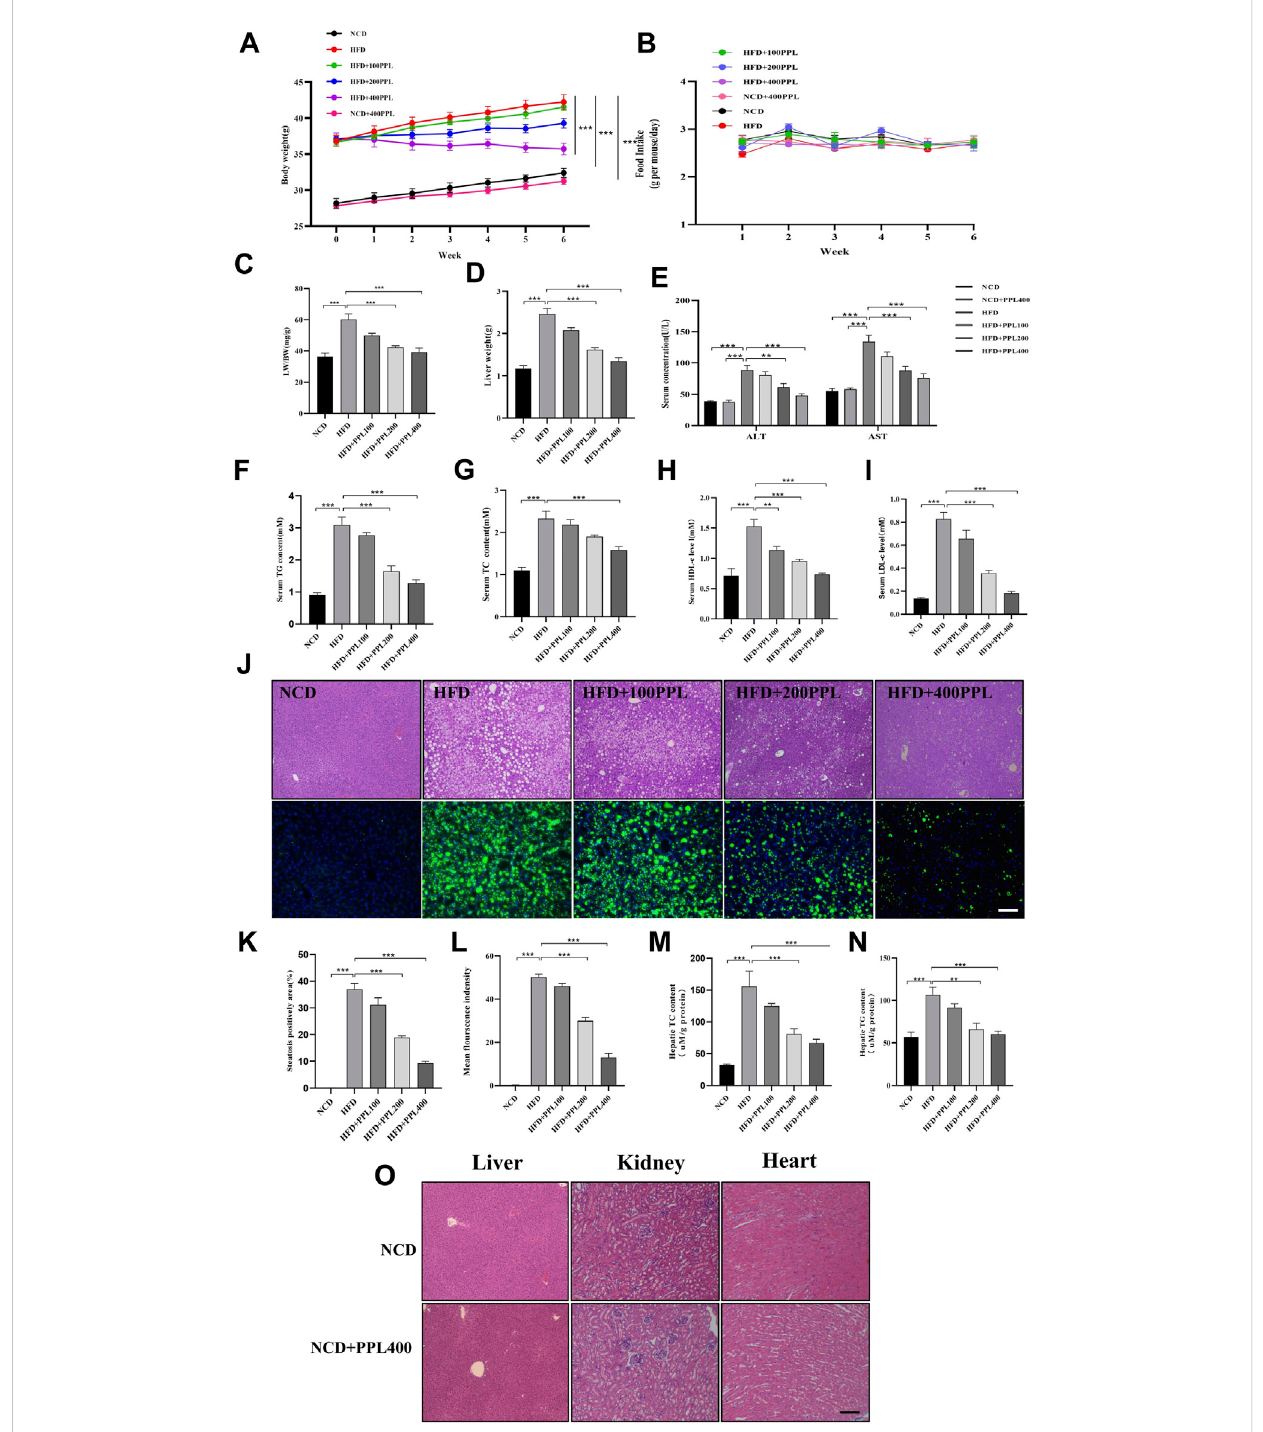
FIGURE 1 PPLalleviatedHFD-inducedobesityand liversteatosisinmale C57BL/6mice. (A) Body weightofHFD-inducedobeseC57BL/6mice werefedeither in the presence or absence of PPL. (B) Weekly food intake pro fi le. (C) LW/BW ratio. (D) Liver weight. (E) Serum ALT and AST activity. (F – I) Serum lipid contentsofTG,TC,HDL-c,andLDL-clevels. (J) TypicalimagesofHE(top)andBODIPY493/503(bottom)stainingofliversections. (K) Steatosispositively area. (L) BODIPY positively stained area. (M,N) Hepatic TC content and TG content. (O) Typical images of HE staining from liver, kidney and heart sections. Magni fi cation: ×200, scale bar: 100 μ m. Data were expressed as the mean ± SEM. Differences among groups were compared by one-way ANOVA. * p < 0.05, ** p < 0.01, *** p < 0.001. (n = 6-7 per